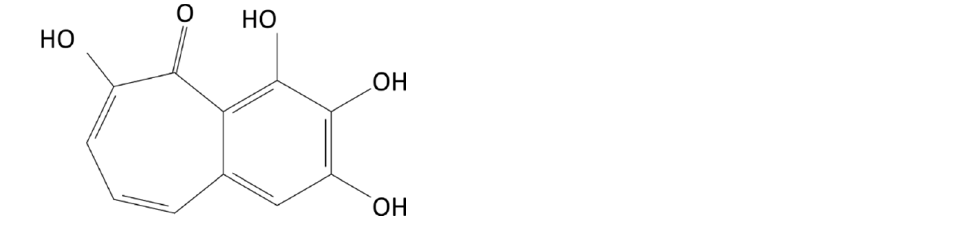
Figure 1. Structure of purpurogallin (PPG; 2,3,4,5-tetrahydroxybenzo[7]annulen-6-one, CAS 569-77-7).